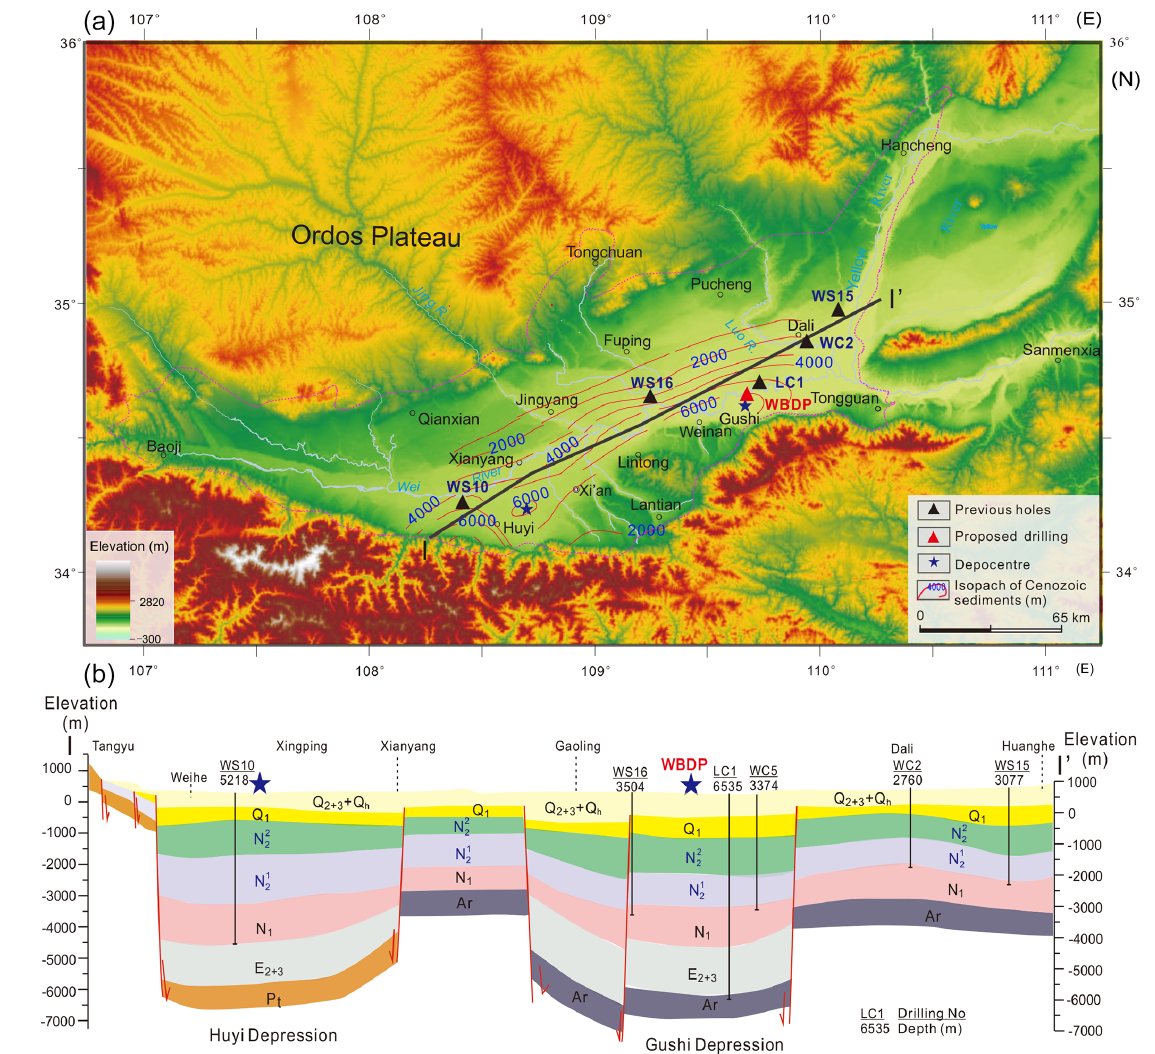
Figure 2. Isopach maps of Cenozoic sediments (a) and a stratigraphic cross section (b) through the Weihe Basin. Blue and red stars indicate the eastern and western